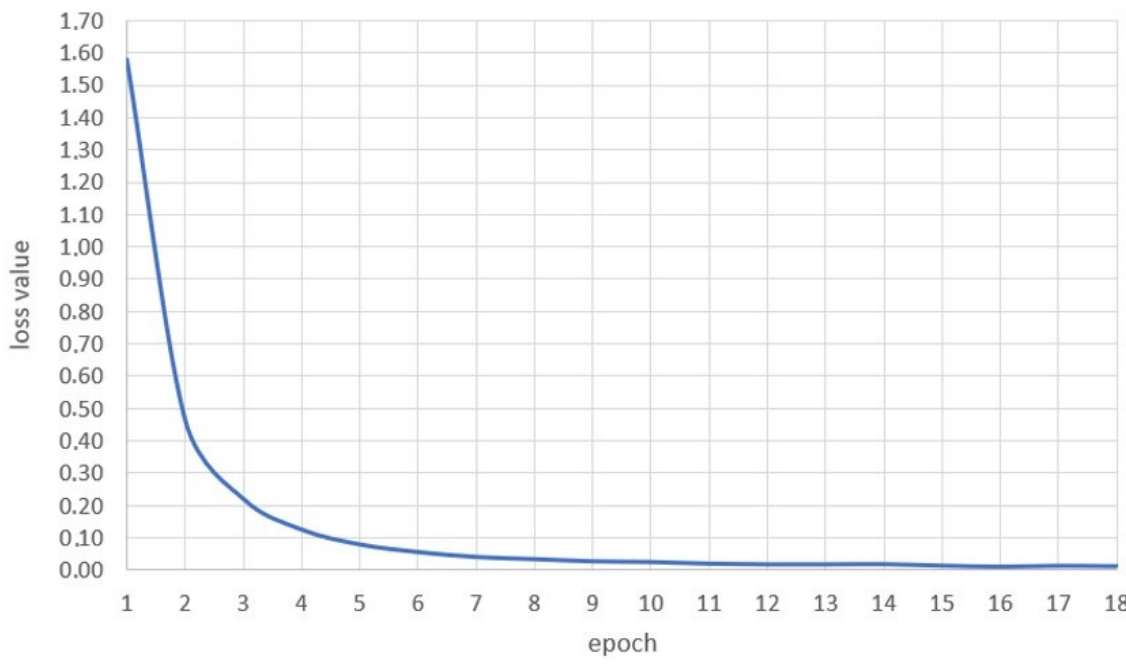
Figure 3. Loss function curve of the network learning process. The parameter that allows determination of the ability of the neural network to assimilate knowledge in the fastest and easiest way is the accuracy of the forecasts made. This is the quotient of the number of correctly recognized datapoints out of the total number of trials. Figure 4 shows a comparison of the validity function values with the values of the validation set.